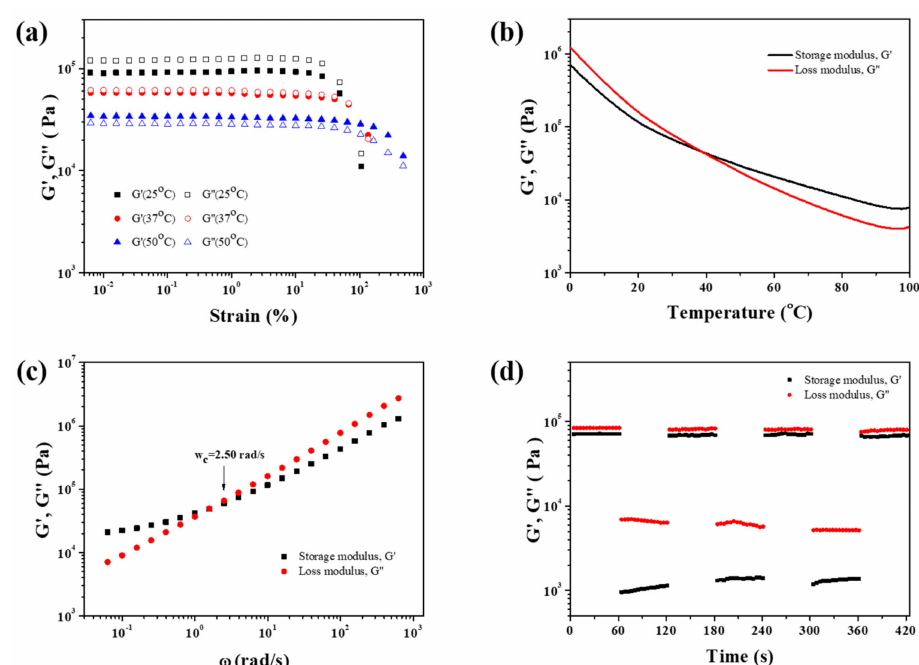
Figure 2. ( a ) Oscillatory strain sweeps of PDMS-COO-E at di ff erent temperatures. ( b ) Dynamic oscillatory temperature sweeps of PDMS-COO-E range from 0 ◦ C to 100 ◦ C at 1 Hz. ( c ) Frequency sweeps of PDMS-COO-E range from 0.01 rad / s to 1000 rad / s with 0.1% strain amplitude at room temperature. ( d ) Continuous step strain measurements of PDMS-COO-E at 25 ◦ C and f = 1 Hz, under a small strain amplitude 0.1% or a large strain amplitude